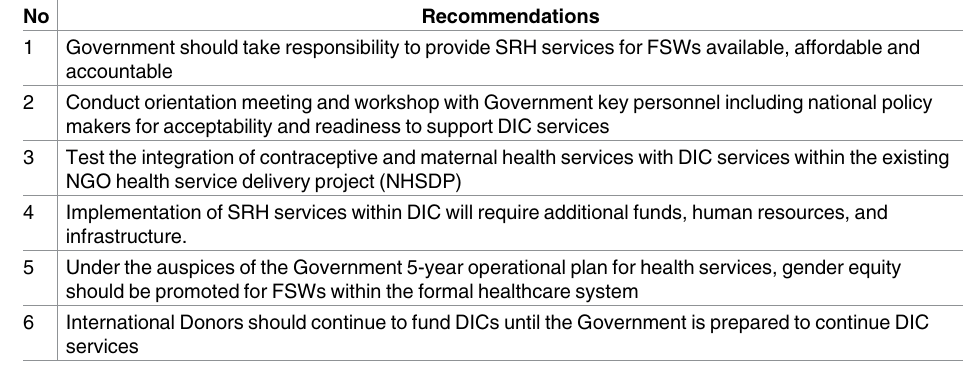
Table 6. Recommendations identified in